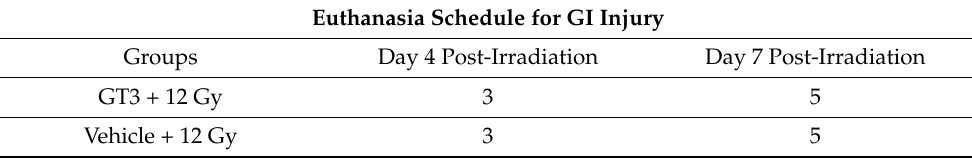
Table 2. Euthanasia schedule for 16 NHPs exposed to 12 Gy TBI for GI